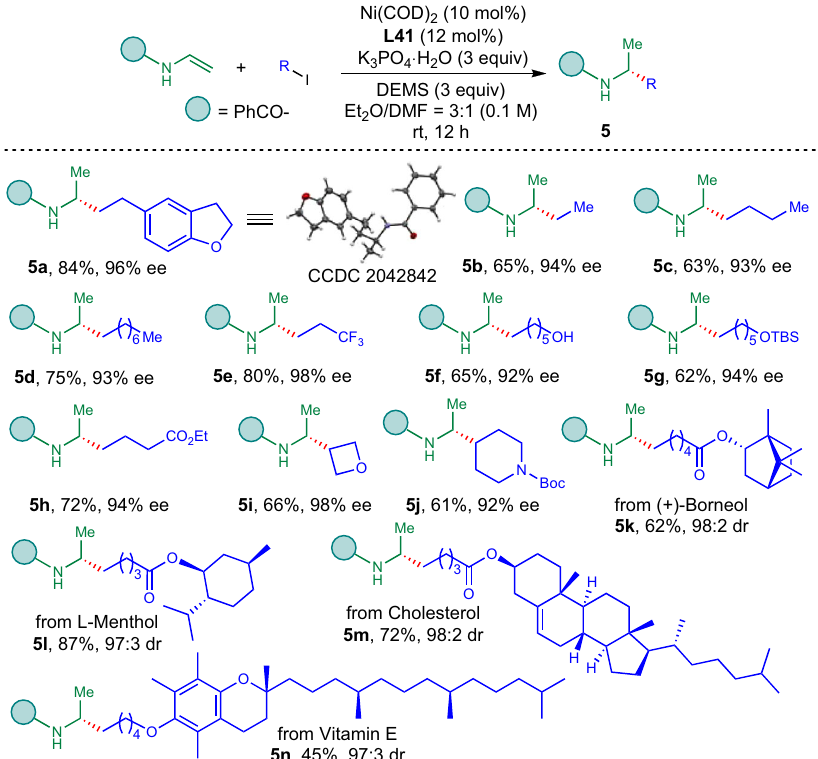
Fig. 4 Scope for alkyl iodides with secondary acyl enamines. The reaction was conducted on 0.2 mmol of acyl enamine and 0.4 mmol of alkyl iodide (2.0 equiv.) under indicated